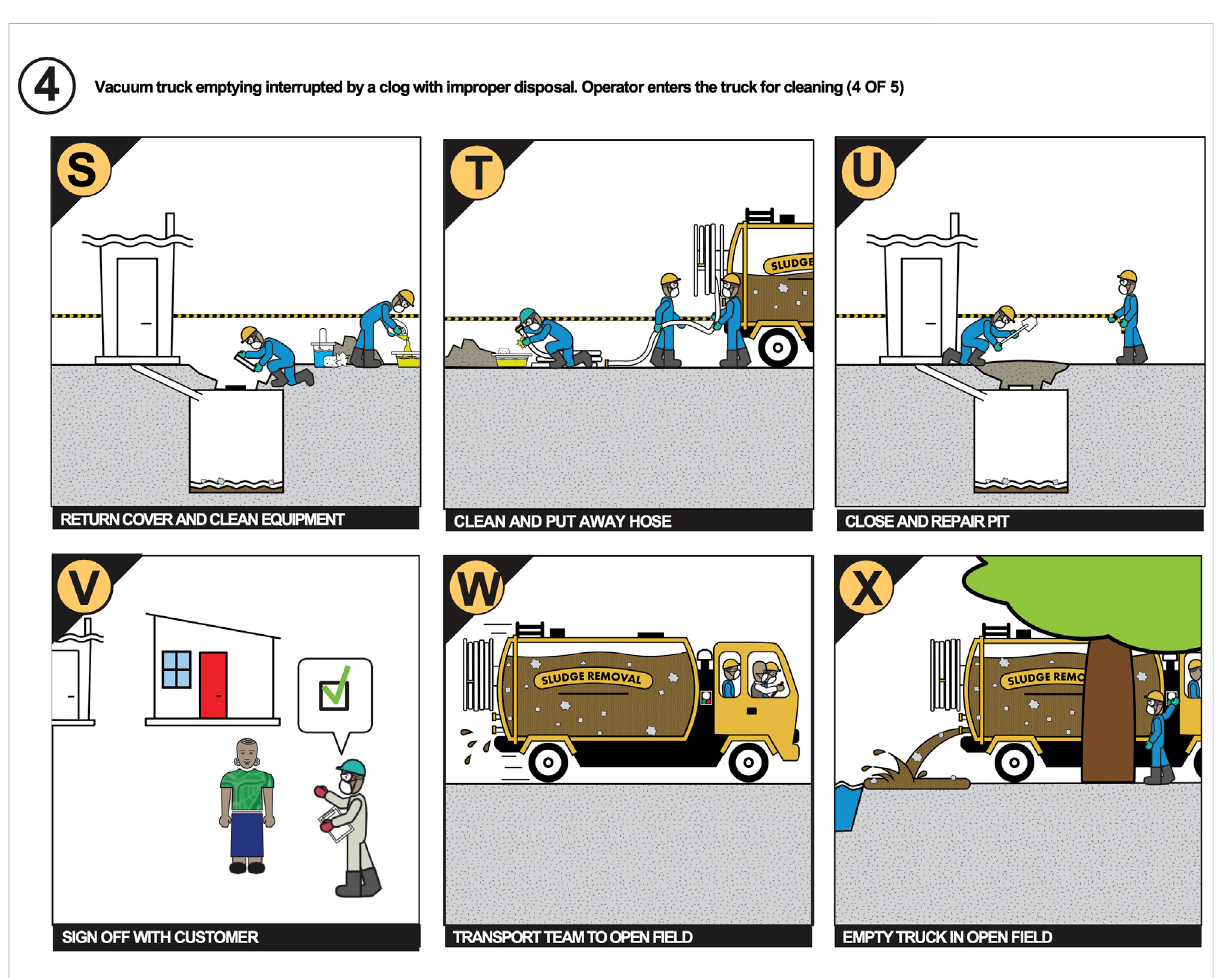
FIGURE 4 Excerpt of vacuum truck emptying interrupted by a clog with improper disposal. Operator enters the truck for cleaning. See Supplementary Material for the complete set. The panel labels correspond to the chronological labels used in the complete set.